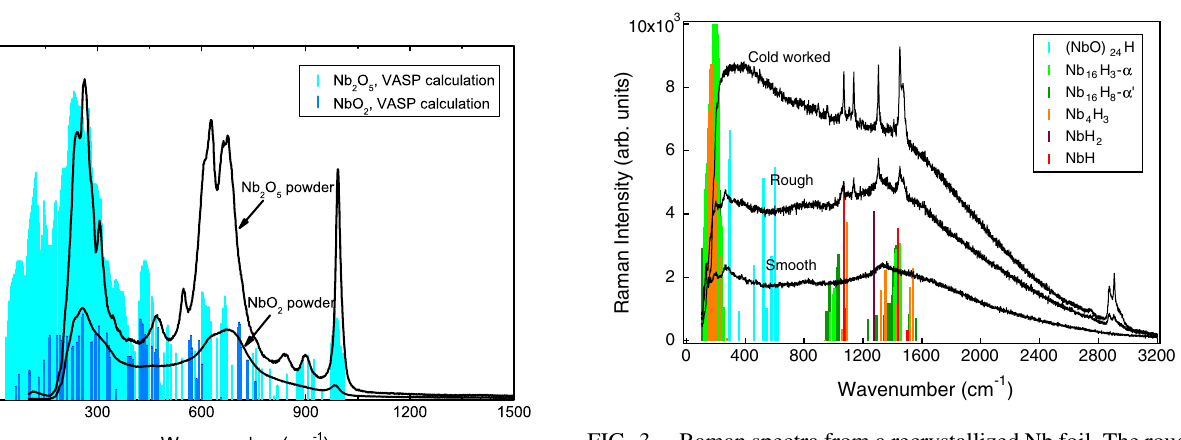
FIG. 3. Raman spectra from a recrystallized Nb foil. The rough spot is likely a pit and the smooth region is outside the pit. The cold-worked region has a spectrum similar to that inside the pit. Vertical lines are the DFT calculated Raman-active modes for various Nb-H complexes as indicated in the inset legend.